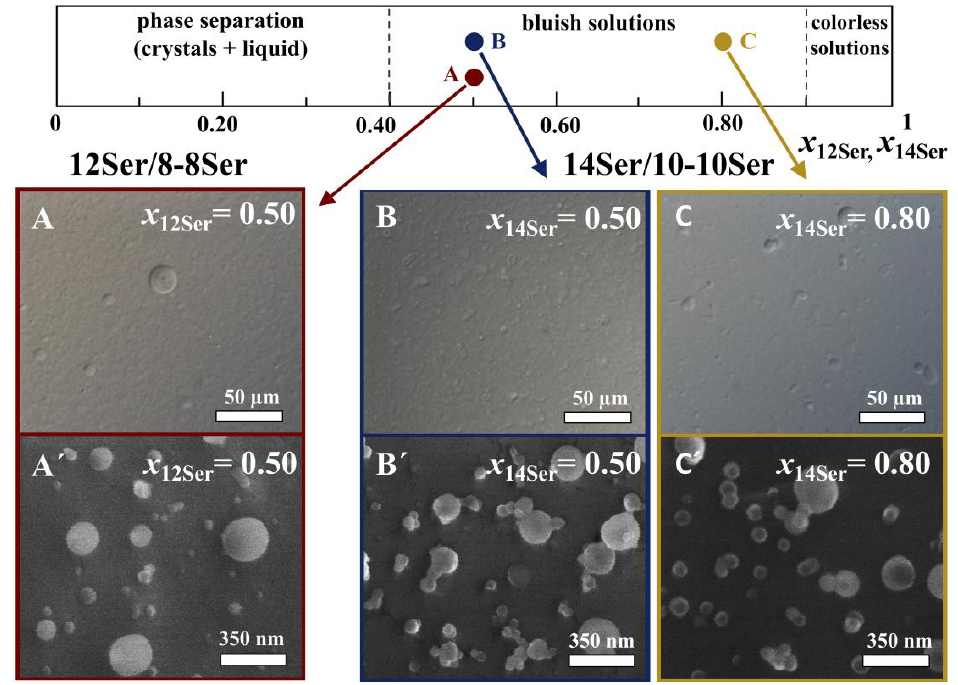
Figure 2. Phase maps and aggregate imaging of the 12Ser/8-8Ser and14Ser/10-10Ser catanionic mixtures, at 0.5 wt% total surfactant and 25.0 ◦ C; x 12Ser and x 14Ser represent the molar fraction of the respective cationic surfactant in the mixture. ( A – C ) are VELM micrographs showing giant µ m-sized vesicles; ( A’ – C’ ) are cryo-SEM micrographs.